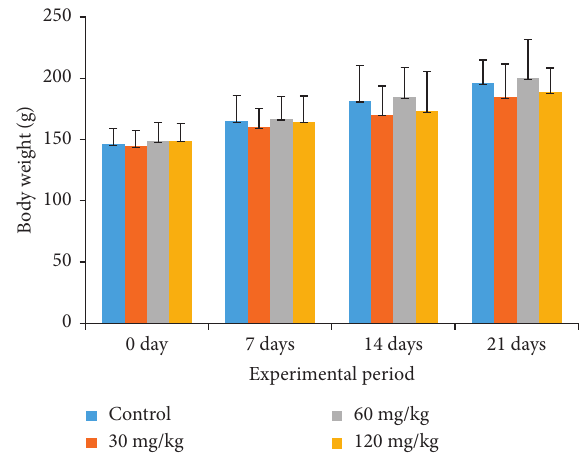
Figure 1: The effects of goose bone on body weight (g) gain. Results are expressed as mean ± SD. ( n � 8). Nonsignificant changes were found when all treatment groups were compared against the control group ( p < 0 . 05) as determined by one-way ANOVA fol- lowed by Dunnett’s multiple comparison tests. Table 1: The effects of goose bone on relative organ weight. Organs